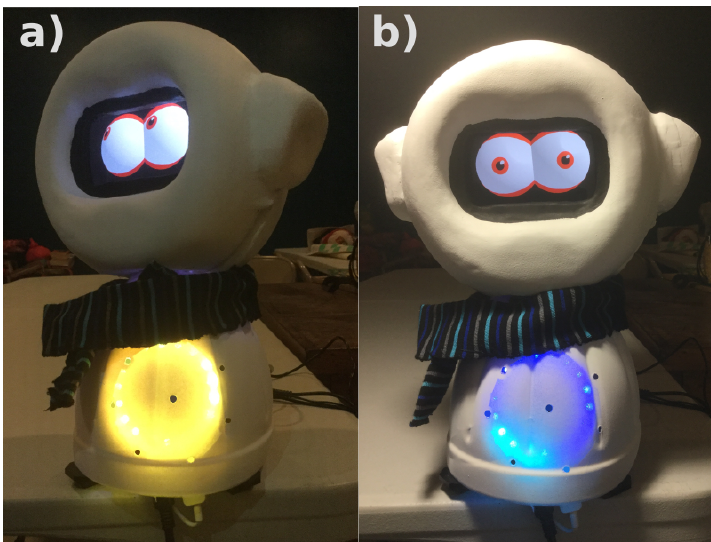
Figure 2. ( a ) The robot Eva is thinking and waiting for the participant’s answer during 10 s; ( b ) Eva is listening to the participant’s